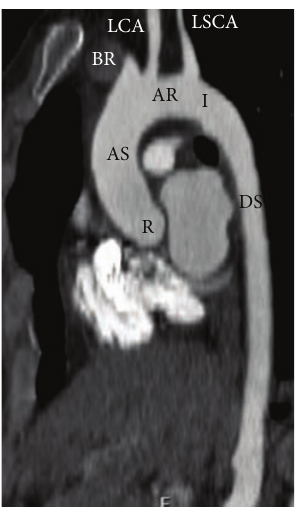
Figure 1: Normal thoracic aorta—sagittal reconstructed CT image of thoracic aorta showing the various segments of thoracic aorta and the arch branch vessels. R: root; AS: ascending aorta; AR: arch; I: isthmus; DS: descending thoracic aorta. BR: brachiocephalic artery; LCA: left common carotid artery; LSCA: left subclavian